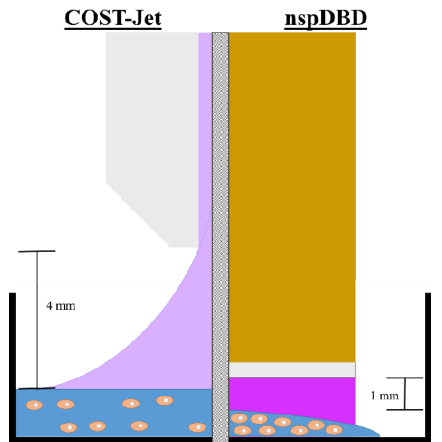
Figure 1. Schematic of plasma treatment setups. The European Cooperation in Science and Technology Reference Microplasma Jet (COST-Jet) was set 4 mm above 500 µL of culture medium or deionized (DI) water. The COST-Jet operated in He with a 0.6% O 2 admixture. The nanosecond pulsed floating-electrode dielectric barrier discharge (nspDBD) was positioned with a 1 mm gap distance above the liquid surface in ambient air. The treatment volume was 100 µL.